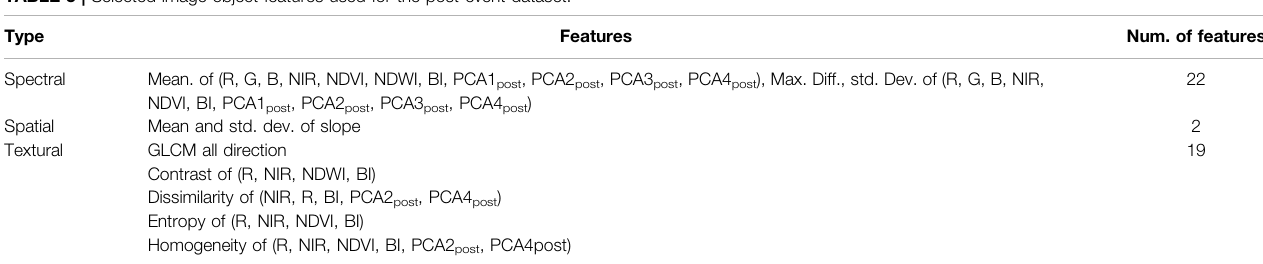
TABLE 3 | Selected image object features used for the post-event